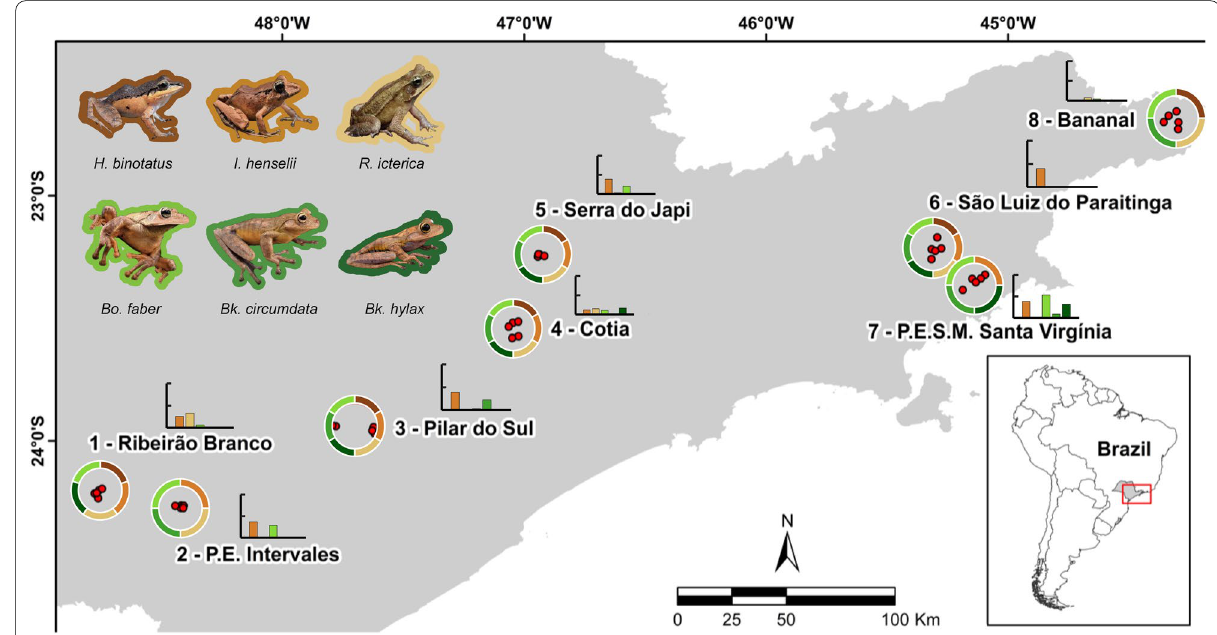
Fig. 1 Occurrence of six focal amphibian species (shown at top left) in eight focal landscapes (circles of 15‑km diameter) and 40 sample sites (five red points per landscape) in the Atlantic Forest in the State of São Paulo, southeastern Brazil. Colored bars within circles indicate species sampled within each landscape. Barplots show relative Batrachochytrium dendrobatidis prevalence among species observed at each landscape. Landscapes are (1) Ribeirão Branco, (2) Intervales State Park, (3) Pilar do Sul, (4) Cotia, (5) Serra do Japi, (6) São Luíz do Paraitinga, (7) Serra do Mar State Park— Núcleo Santa Virgínia, and (8)